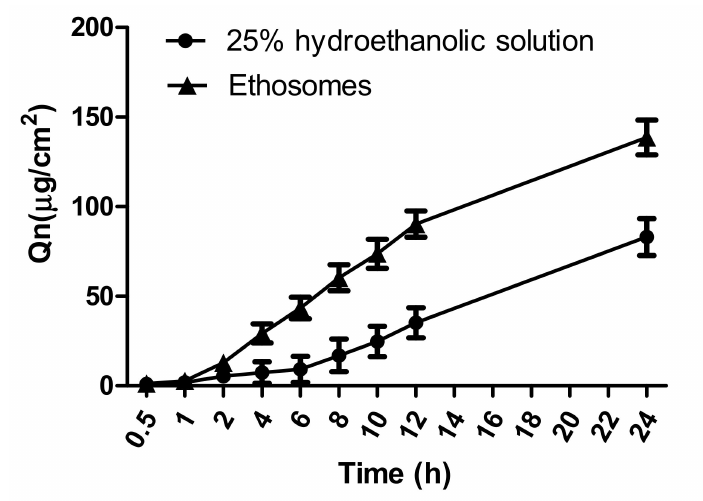
Figure 6. In-vitro permeation profiles of paeonol formulations through the rat skin ( n = 3).